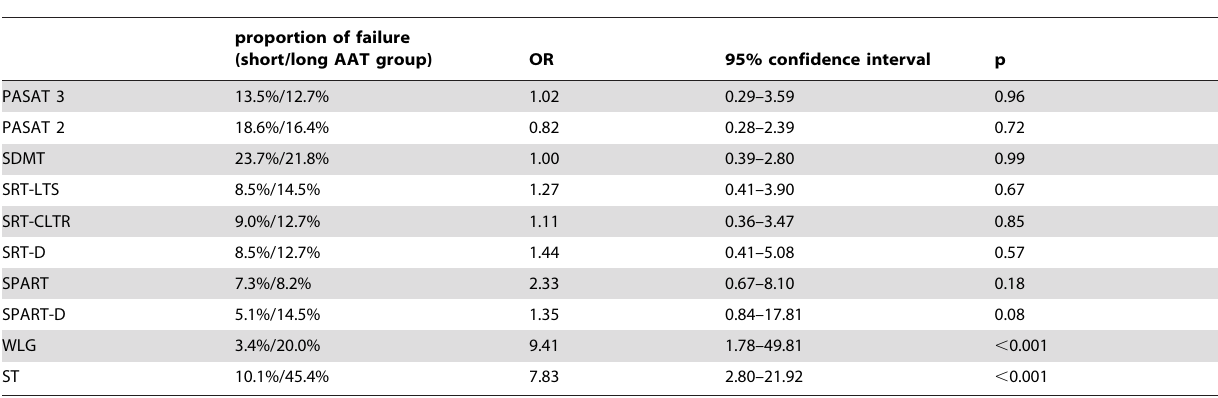
Table 4. Neuropsychological performance of MS subjects according to CNR1 (AAT)n polymorphism.